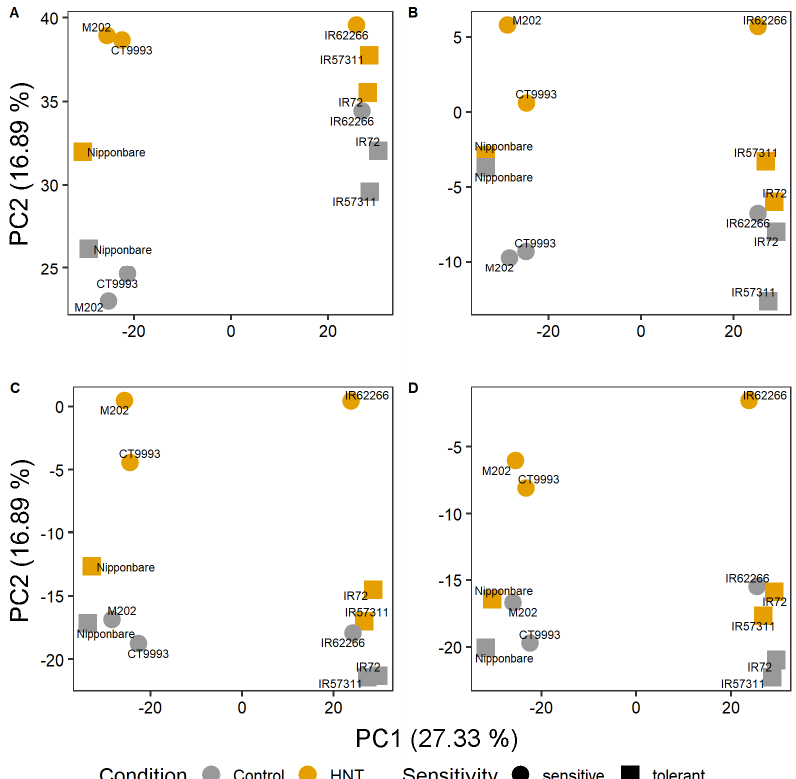
Figure 6. Principle component analysis of RNA-Seq raw counts from samples of all four rice leaf segments exposed to control and HNT conditions.